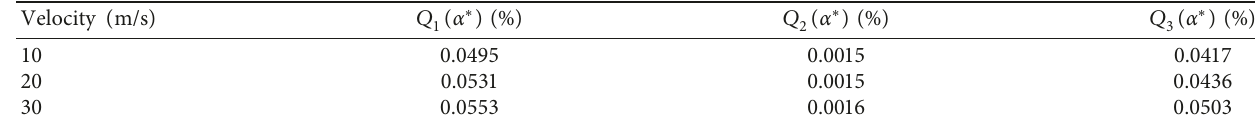
Table 6: Estimation results for different vehicle velocity.